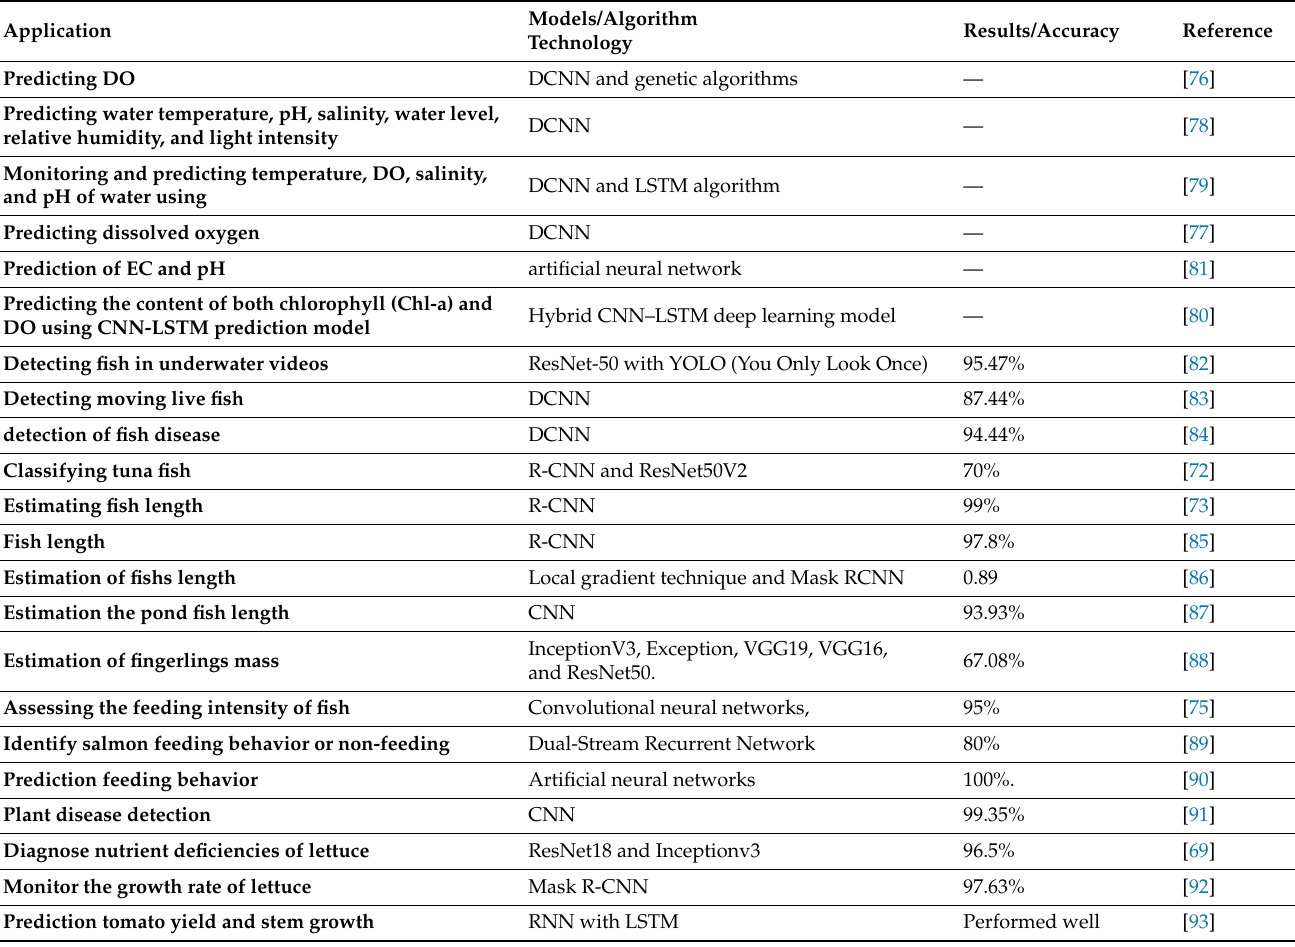
Table 5. Prediction of water quality parameters, detection and species classification, estimation of fish size, feeding decisions of fish, and plant detection using deep